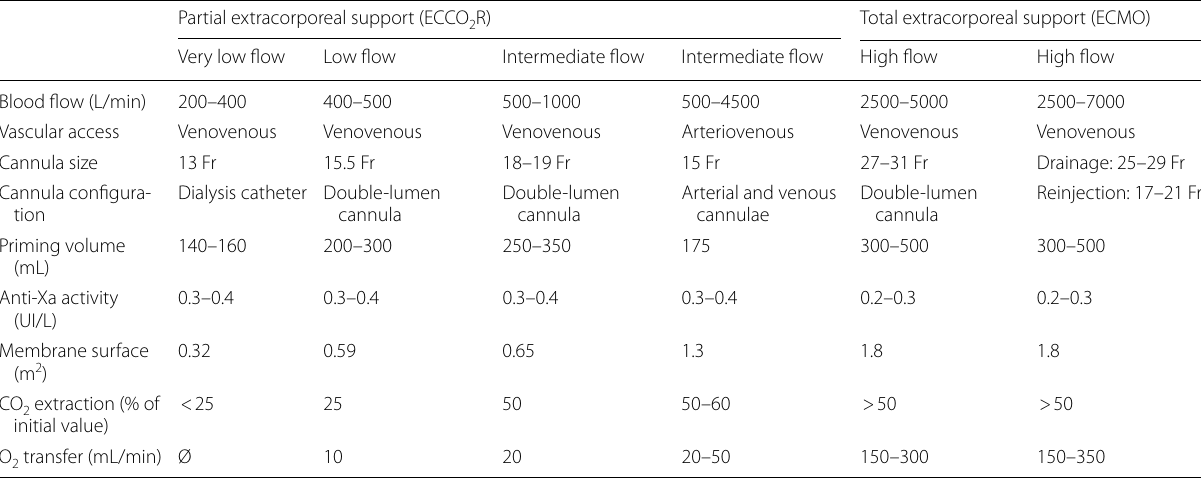
R and VV-ECMO systems 2